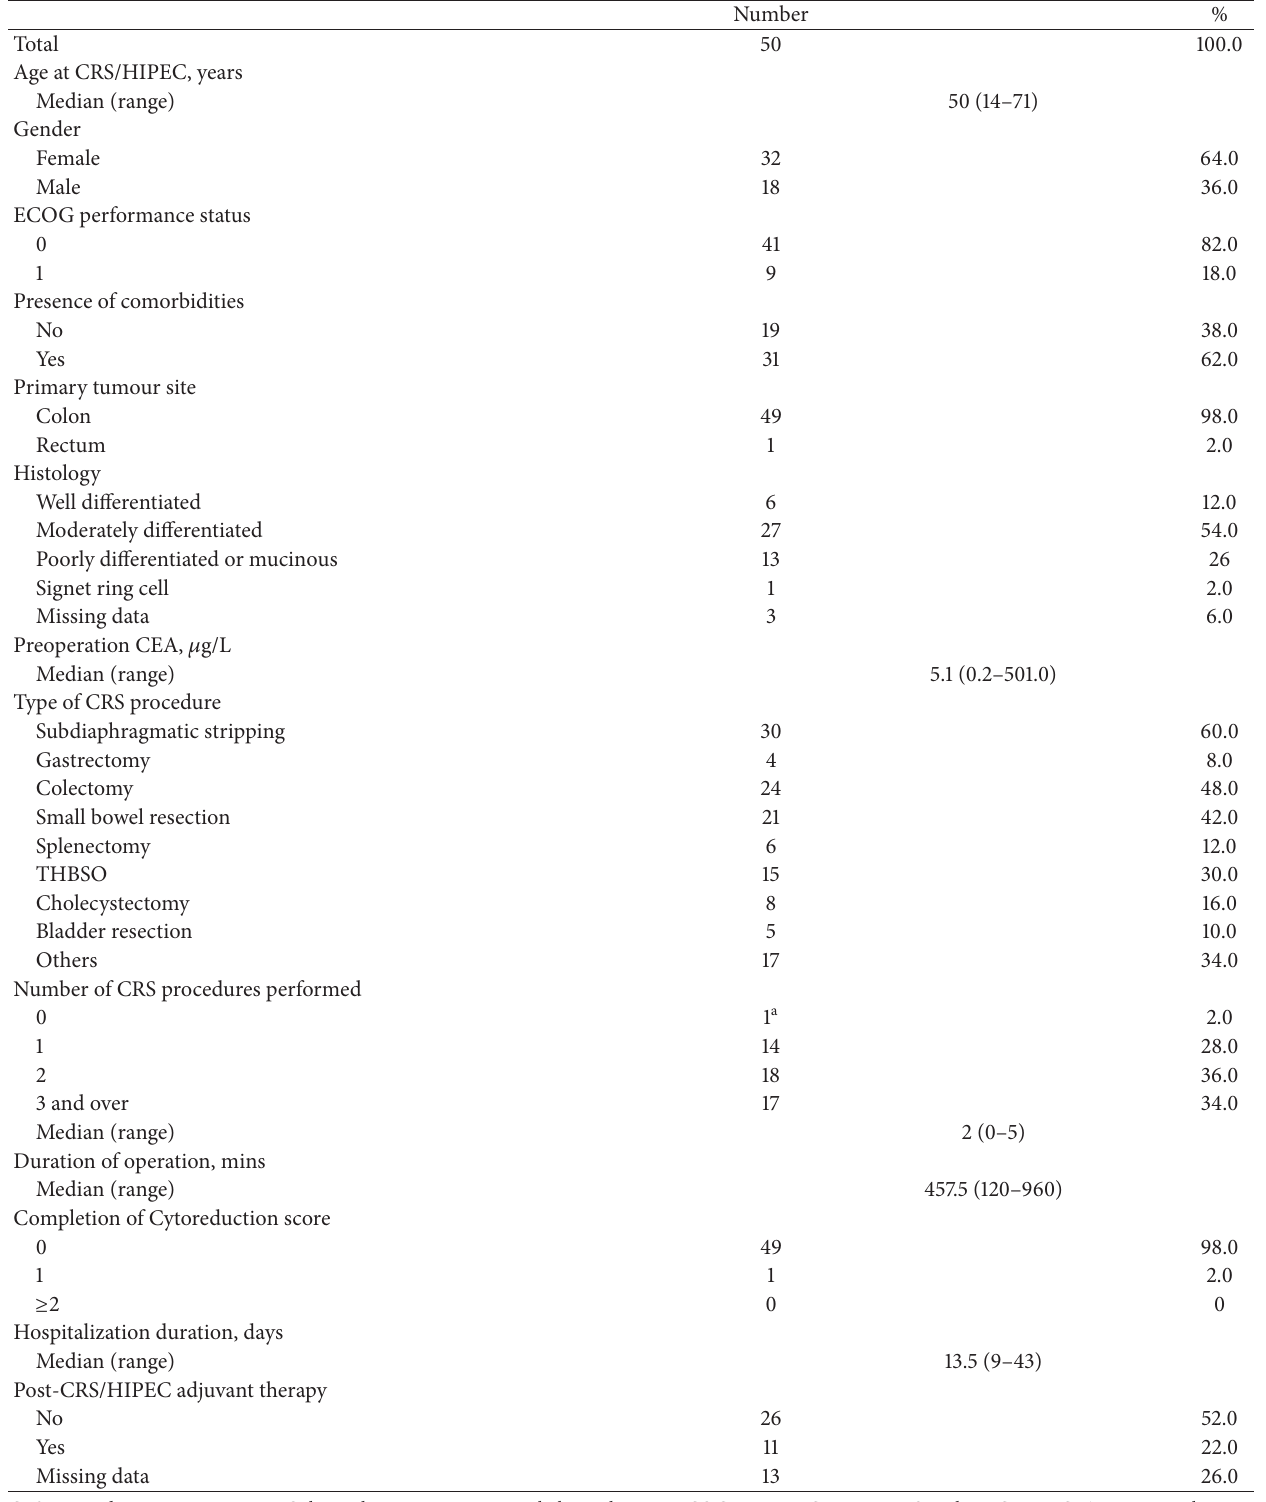
Table 1: Baseline demographics and operative